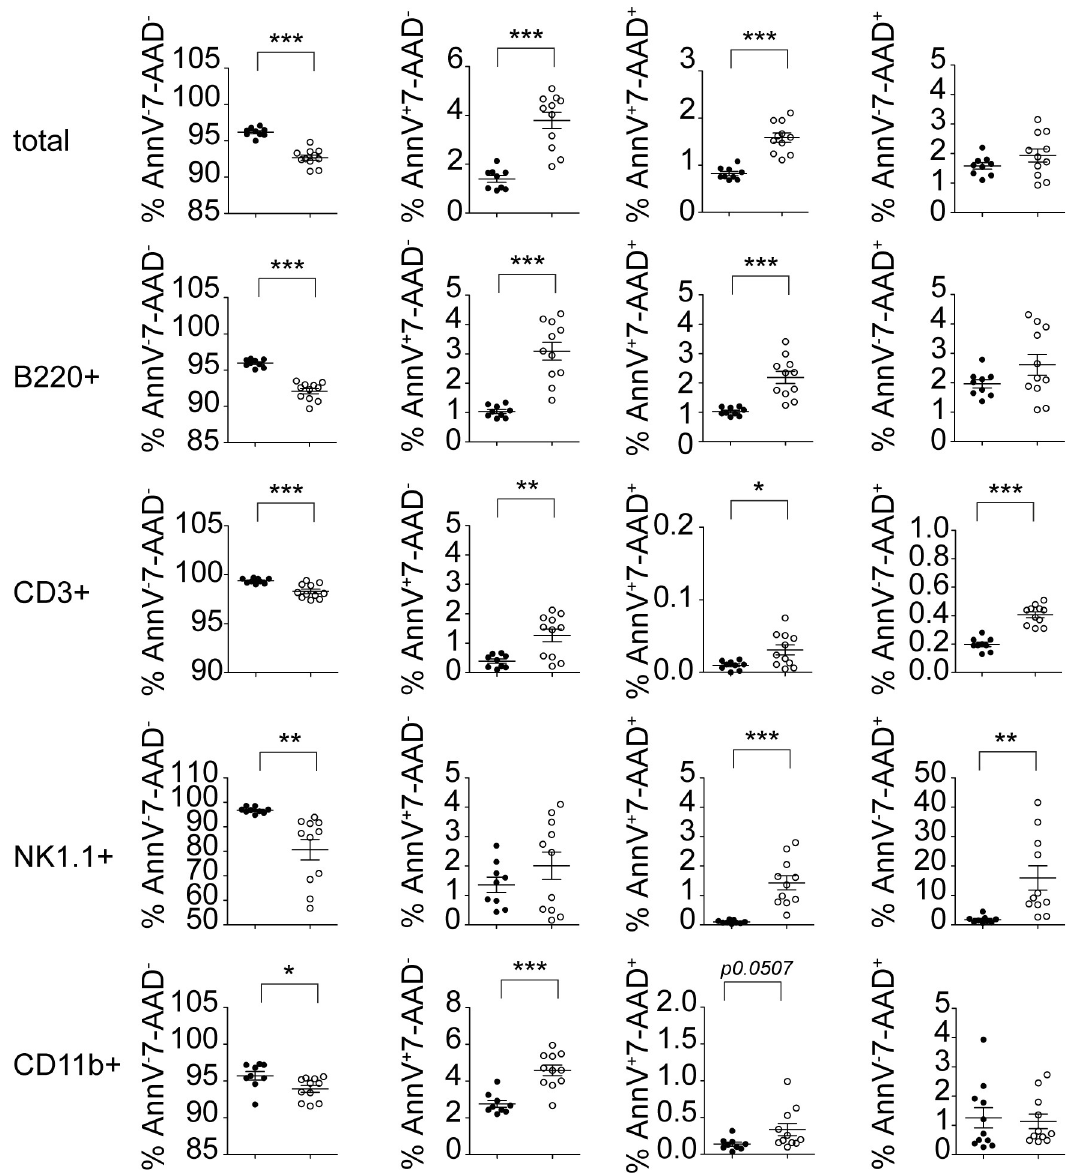
Fig 5. Absence of DDX3X increases hematopoietic cell death. Spleens were isolated from uninfected Ddx3x fl/y and Ddx3x fl/y Vav-iCre mice and stained with fluorochrome-coupled Annexin V plus the indicated surface markers, followed by staining with 7-AAD. Percentage of Annexin V + and/or 7AAD + cells are shown, as indicated (n = 9 for Ddx3x fl/y and 11 for Ddx3x fl/y Vav-iCre mice, analyzed in 2 independent experiments). Statistical analysis was carried out using unpaired, two-tailed Student’s t -test. Mean and standard error of the mean (SEM) are indicated in the graphs. � P < 0.05, �� P < 0.01, ��� P <